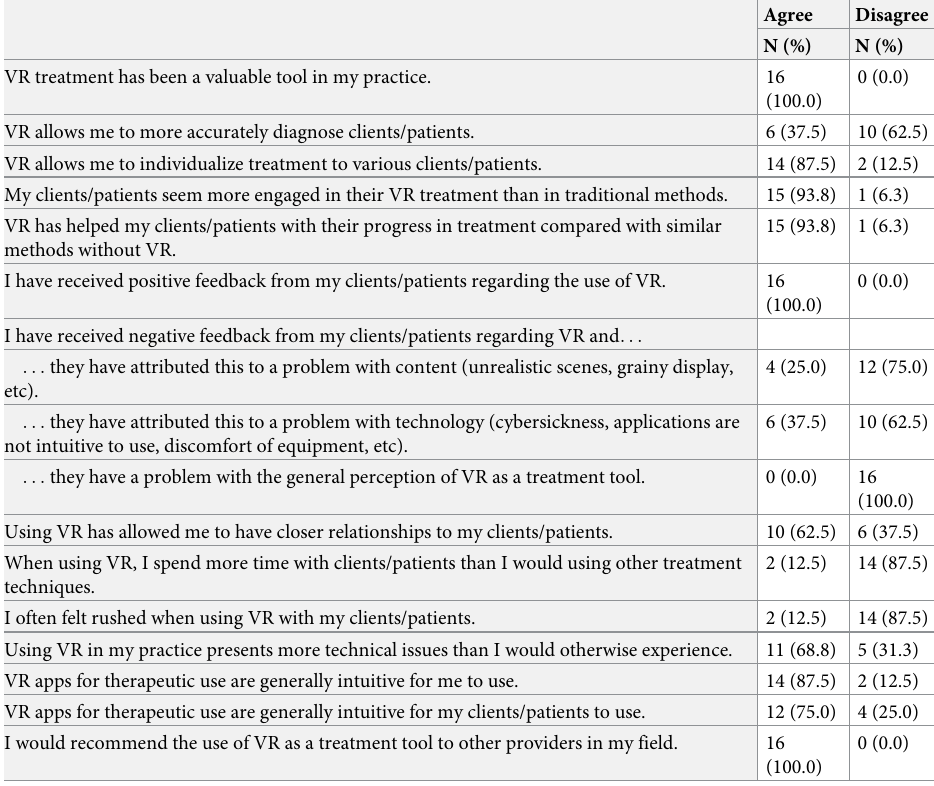
Agree Disagree N (%) N (%) 0 (0.0) (100.0) 6